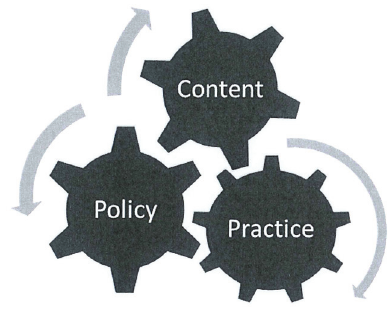
Figure 1: The interlinking of content, policy and